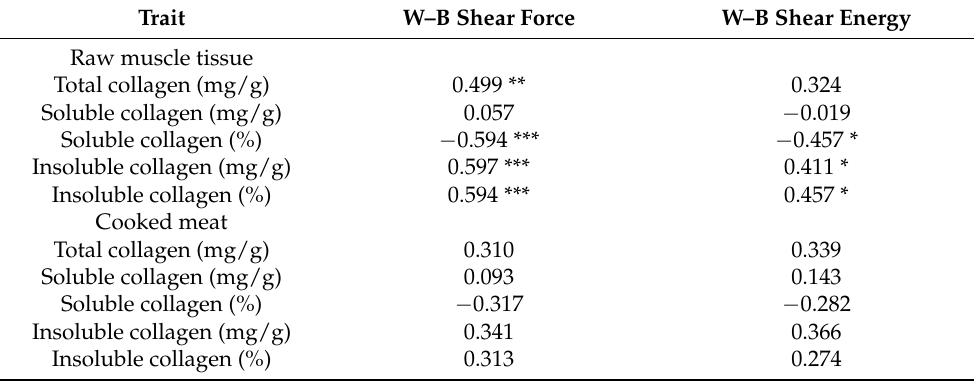
Table 5. The Pearson correlation coefficients between Warner–Bratzler shear force and energy and collagen fractions content in raw muscle tissue and cooked meat of beaver ( n = 30). Trait W–B Shear Force W–B Shear Energy Raw muscle tissue Total collagen (mg/g) 0.499 ** 0.324 Soluble collagen (mg/g) 0.057 − 0.019 Soluble collagen (%) − 0.594 *** − 0.457 * Insoluble collagen (mg/g) 0.597 *** 0.411 * Insoluble collagen (%) 0.594 *** 0.457 * Cooked meat Total collagen (mg/g) 0.310 0.339 Soluble collagen (mg/g) 0.093 0.143 Soluble collagen (%) − 0.317 − 0.282 Insoluble collagen (mg/g) 0.341 0.366